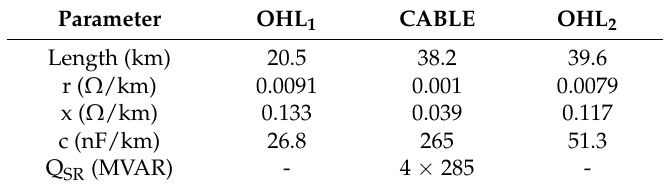
Table A11. Parameters of mixed overhead-cable transmission line—new link (double